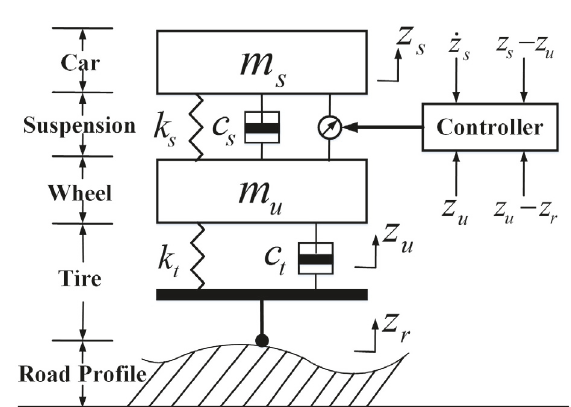
Figure 1: The simplified structure of quarter vehicle active suspen-